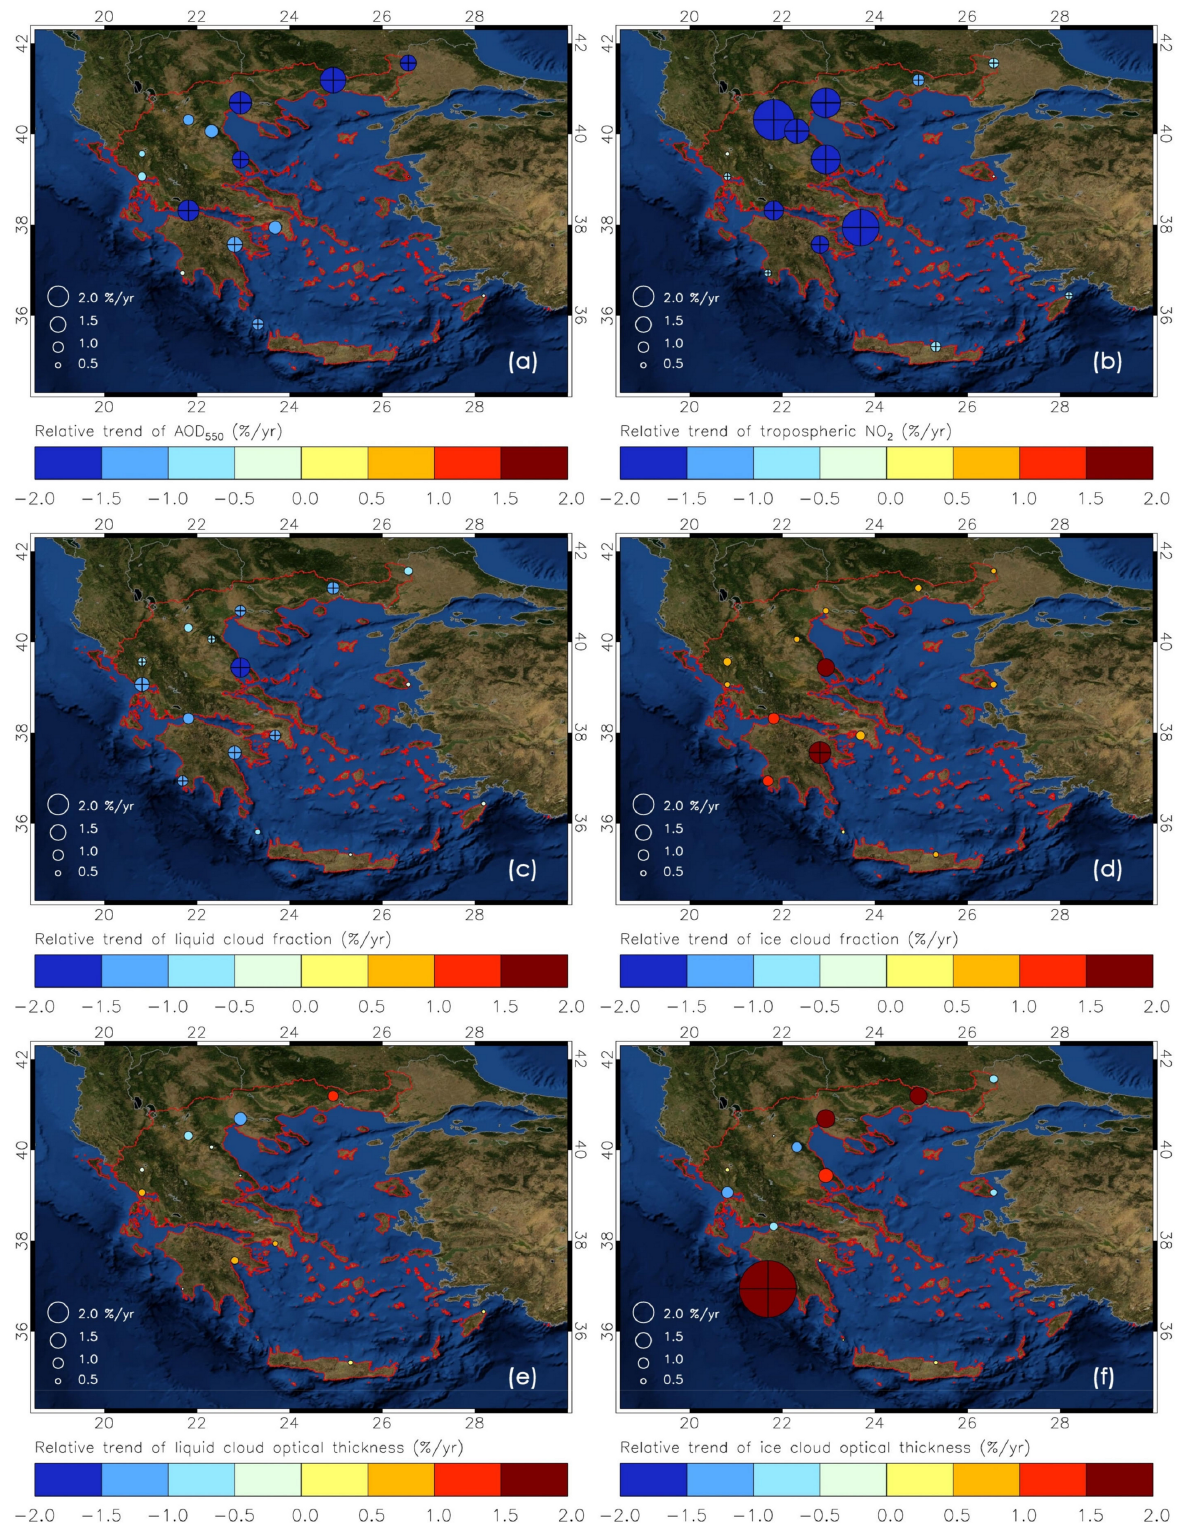
Figure 10. Relative trend (to the first year) of ( a ) AOD 550 , ( b ) tropospheric NO 2 , ( c ) liquid cloud fraction and ( d ) ice cloud fraction, ( e ) liquid cloud optical thickness and ( f ) ice cloud optical thickness for the period 2005–2019 over 16 locations in Greece. Statistically significant trends at the 95% confidence level are indicated with a cross. Aerosol- and cloud-related parameters are from MODIS/Aqua and tropospheric NO 2 from